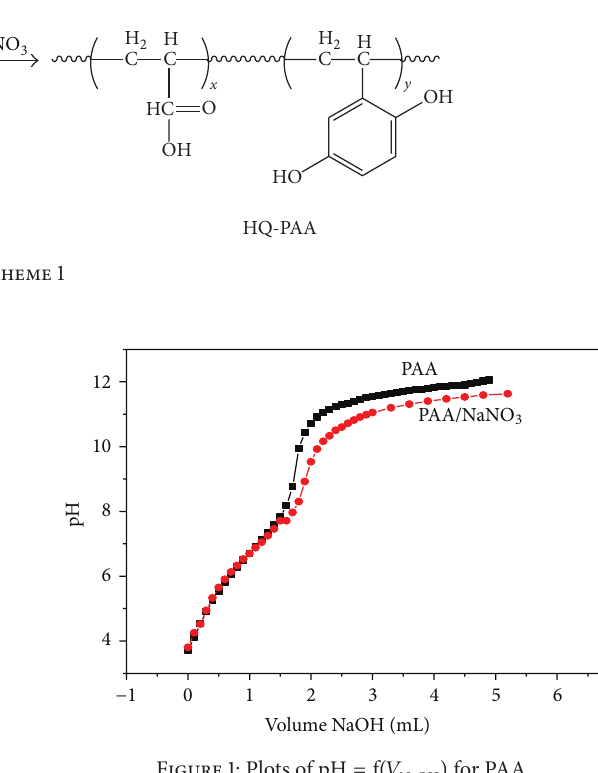
Figure 1: Plots of pH = f (𝑉